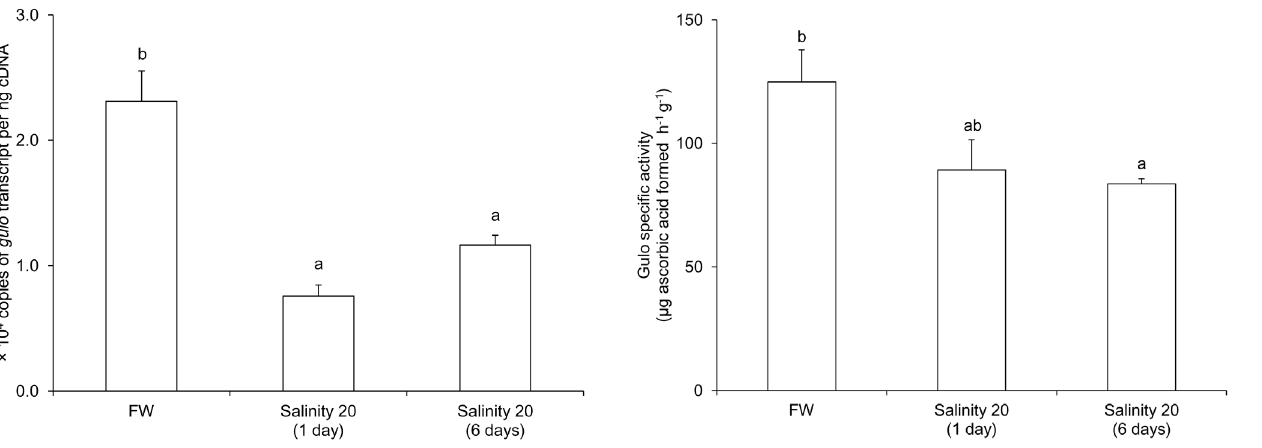
Figure 5. Absolute quantification (copies of transcript per ng cDNA) of mRNA expression of gulonolactoneoxidase ( gulo ) from the kidney of Himanturasignifer kept in freshwater (FW; control) or exposed to brackish water (salinity 20) for 1 or 6 days after a 4-day progressive increase in salinity. Results represent mean 6 S. E. M. (N=5). Means not sharing the same letter are significantly different ( P , 0.05).